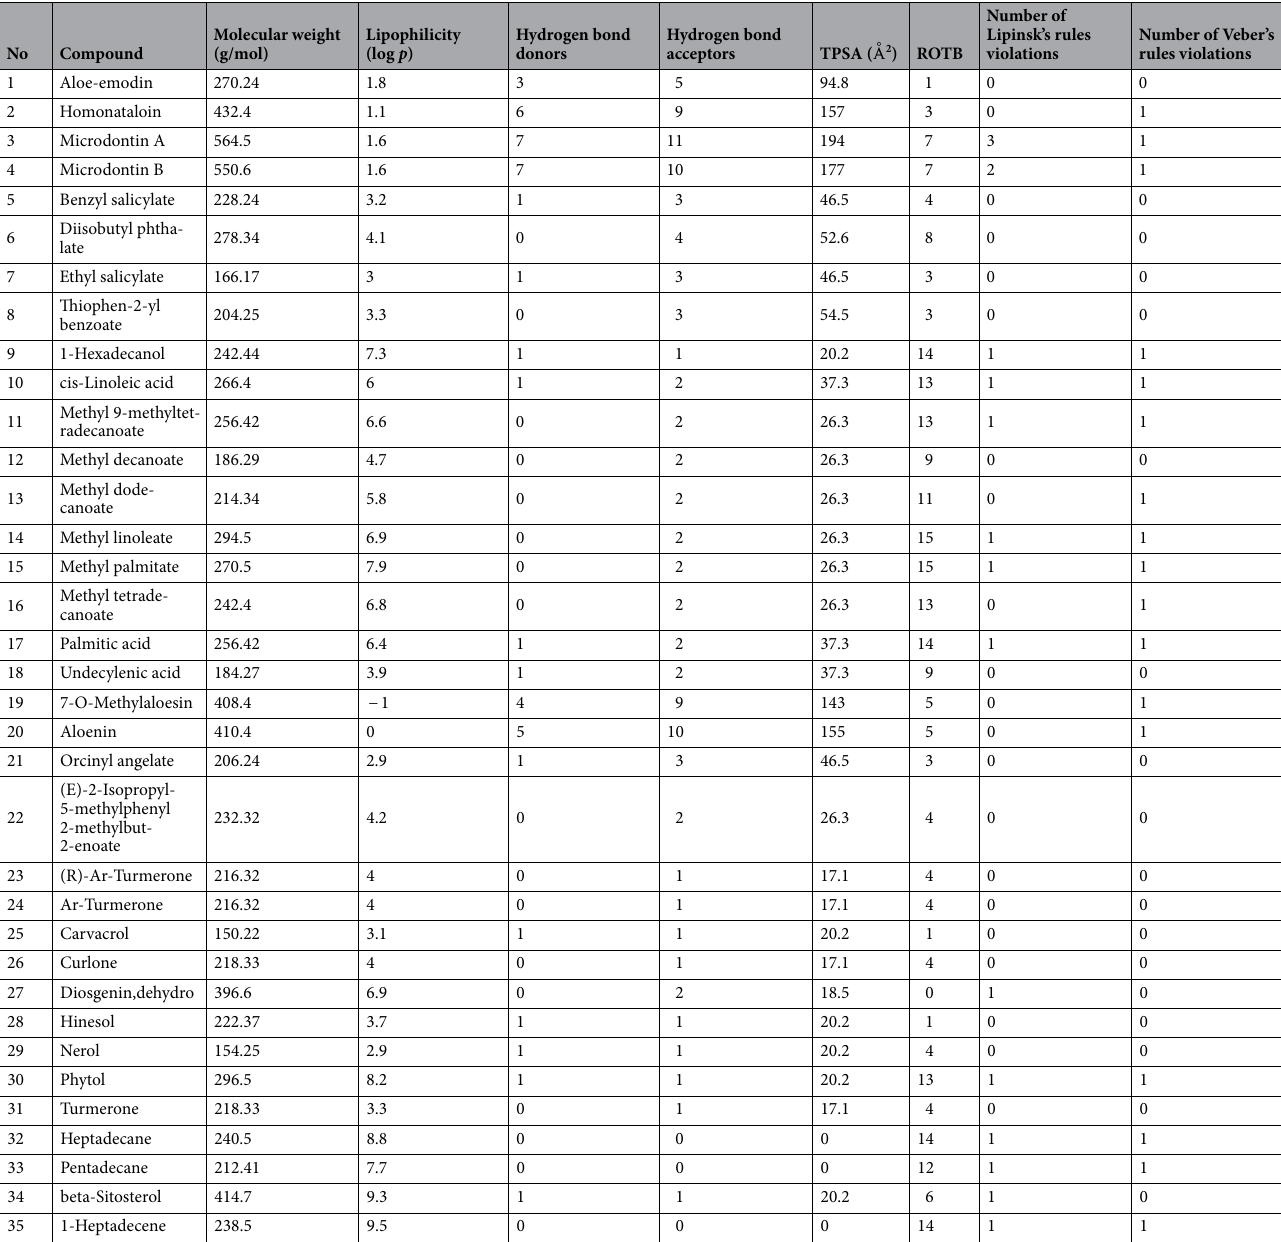
Table 1. Lipinski’s rule of five and Veber’s rule for drug-likeness analysis of Ethiopian indigenous aloes’ phytochemicals. TPSA topological polar surface area, ROTB number of rotatable